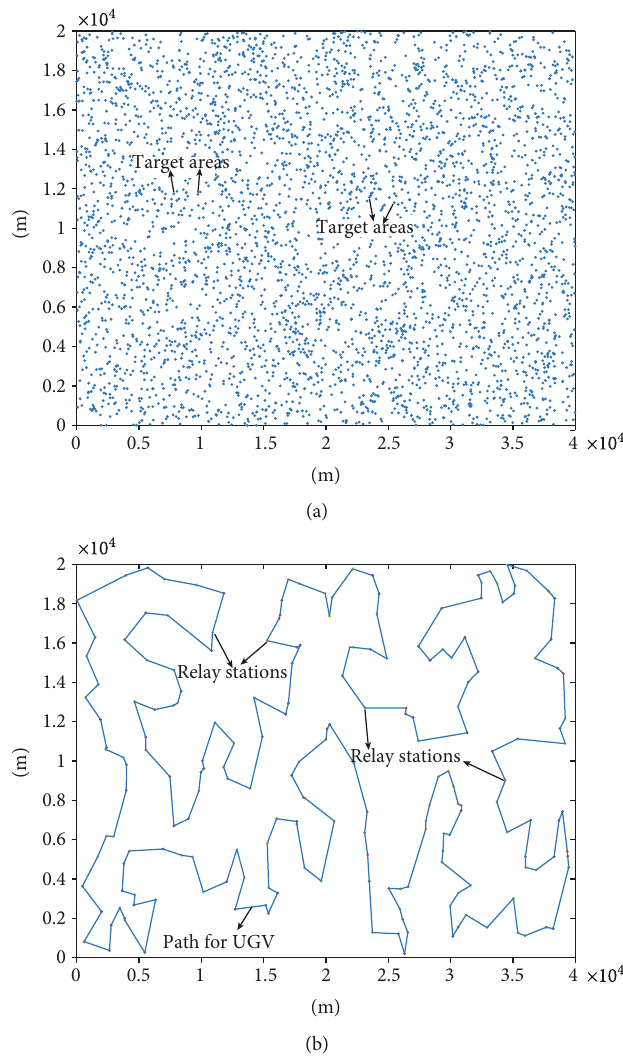
Figure 9: The initial positions of the target areas and the experimental results of the fi rst two stages: (a) the initial positions of these target areas; (b) the clustering and path planning results for the